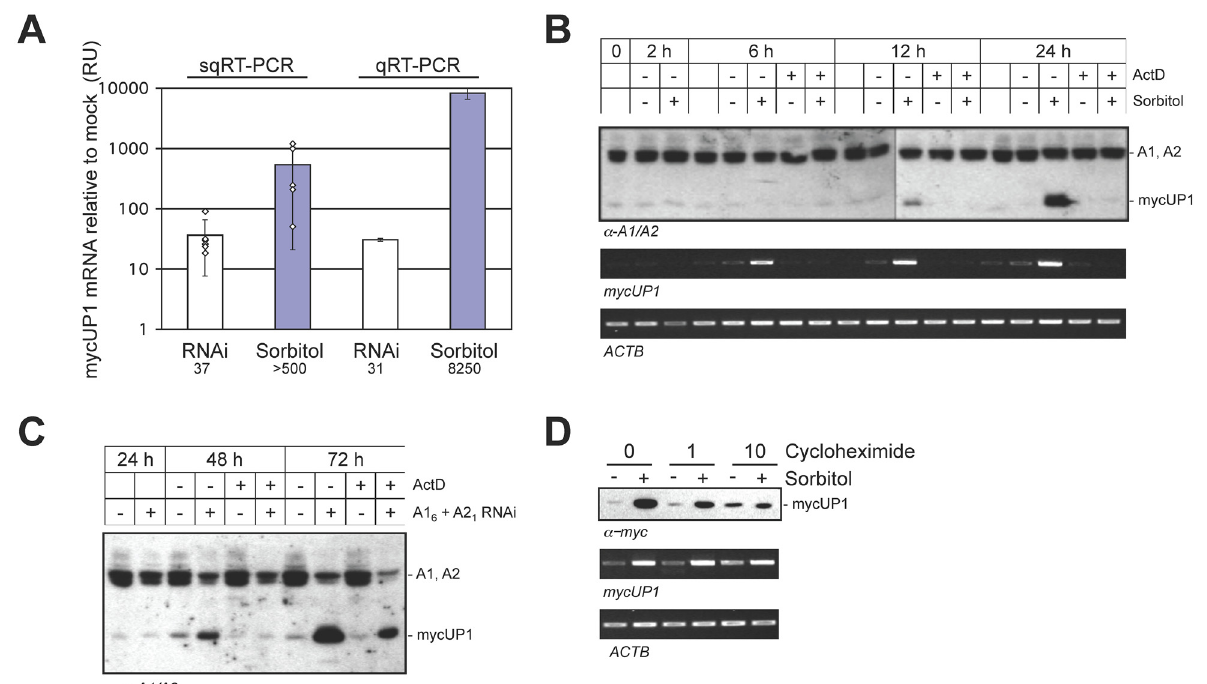
Fig 2. The depletion of nuclear hnRNP A1 and A2 stimulates the transcription of mycUP1. A , Steady-state levels of mycUP1 transcripts measured by semi-quantitative or real-time quantitative RT-PCR (sqRT-PCR or qRT-PCR). At least 5 independent depletion experiments (A1 6 +A2 1 vs Luc) and sorbitol treatments (0 or 600 mM) were analyzed by sqRT-PCR (examples are shown in Fig B in S1 File). Fold increases are represented by white diamonds over an averaged logarithmic histogram. Numbers below the histograms indicate averaged fold stimulation in mycUP1 transcripts. B , Actinomycin D (ActD) abrogates the increase in mycUP1 protein and RNA expression following osmotic shock. The top panel represents a western with the A1/A2 antibody and the results of sqRT-PCR for mycUP1 and actin (ACTB) are shown below. C , ActD abrogates the increase in mycUP1 protein expression associated with the knockdown of A1 and A2. Western analysis of mycUP1 protein expression is shown at different times after siRNA treatment with or without ActD for the last 24 hours of each period. D , HCT116 cells expressing mycUP1 were treated with 1 or 10 μ g/ml of cycloheximide 1 hour prior to sorbitol treatment. The mycUP1 protein and RNA levels are shown. Duplicate experiments with quantitated mycUP1 transcript levels are provided in Fig C in S1 File.